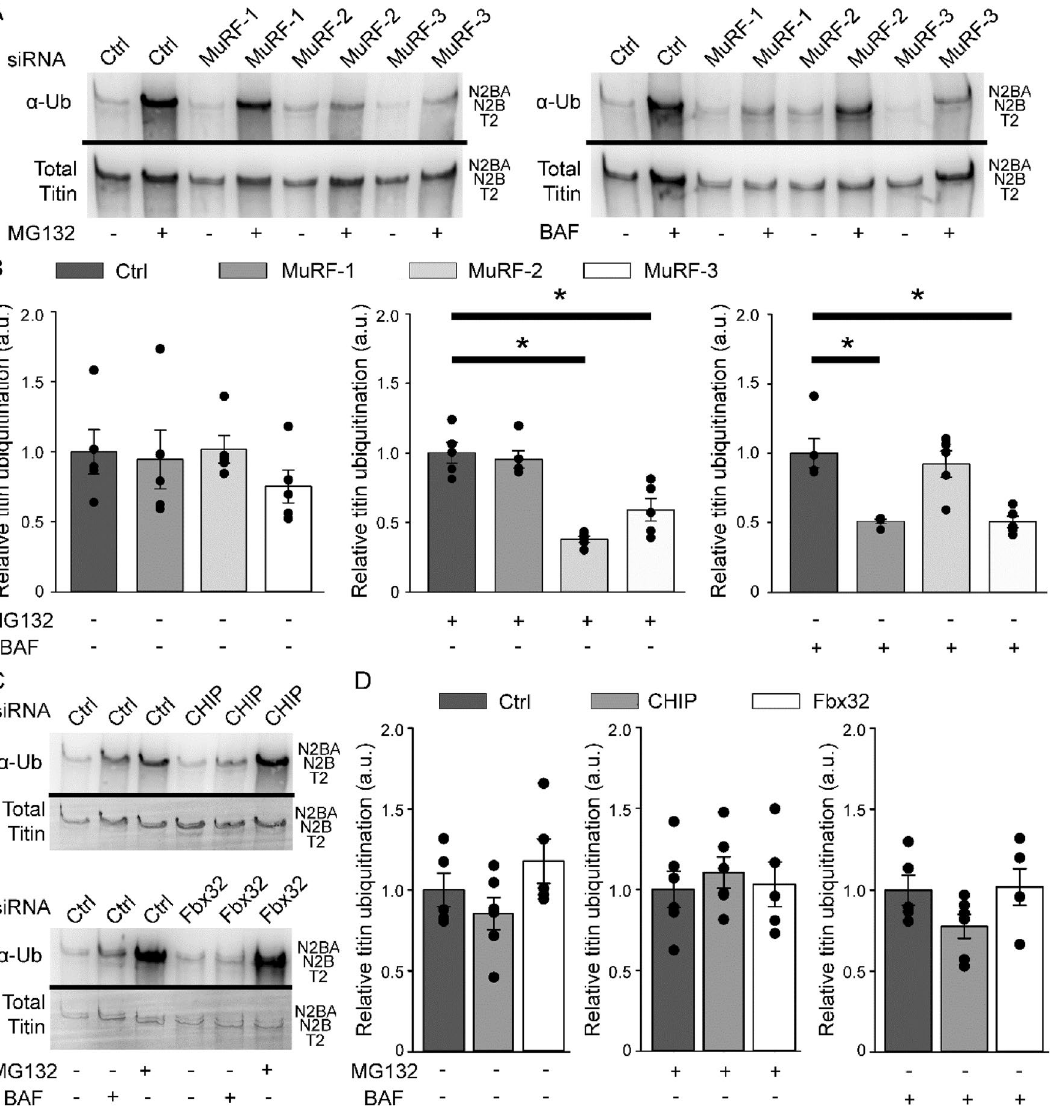
Figure 4. Differential autophagy- or proteasome-related ubiquitination of titin. Cardiomyocytes were treated with siRNAs and 72 h later with MG132 or BAF. ( A / C ) Representative Western blot images of siRNA treated cardiomyocytes with or without inhibition. Analysis of titin ubiquitination levels after MuRF-1, -2 or -3 ( B ) or CHIP or Fbx32 ( D ) siRNA treatment. Either Coomassie stained membranes or an antibody targeting titin PEVK was used in titin blot as a marker for titin loading. Data are shown as mean ± SEM (n = 4–6). Asterisks ( P < 0.05 in one-way ANOVA with Bonferroni t -test) mark statistical significance. BAF = bafilomycin; Ctrl = control; MG132 = proteasome inhibitor; α-Ub = anti-Ubiquitin